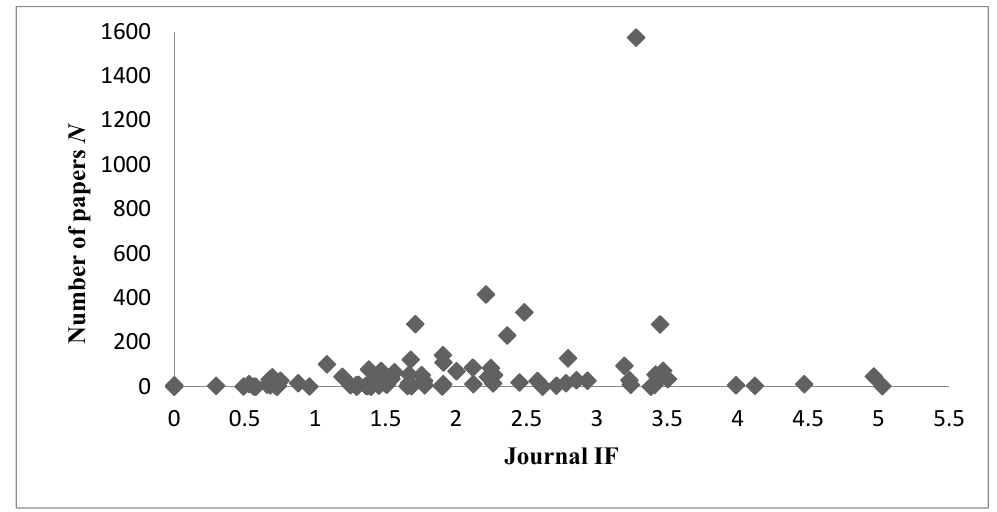
Figure 3. Number N of papers published in 89 journals in the field of health care sciences and services as a function of their impact factors (IFs) during 2007–2014.